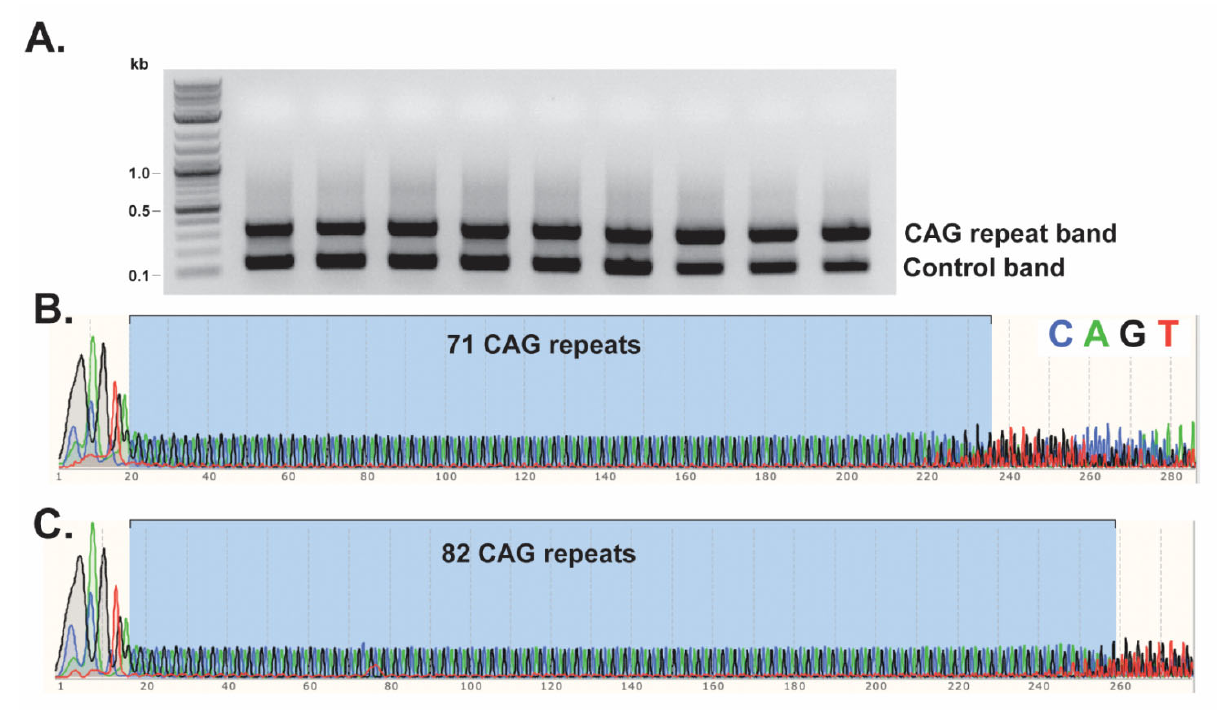
Figure 2. Novel SCA1 mice have spontaneous reduction in CAG repeats in ATXN1[82Q] transgene. PCR products of the CAG repeat region of the ATXN1[82Q] transgene from triple transgenic SCA1 mice on a 1% agarose gel ( A ). Lanes represent different animals, with the upper band showing the PCR product of CAG repeats and the lower band showing the control PCR product. Chromatograms of the CAG repeat sequence from the ATXN1[82Q] transgene of novel SCA1 triple transgenic mice ( B ) and ATXN1[82Q] progenitor mice ( C ). Chromatograms were made using SnapGene Viewer 6.0 software.